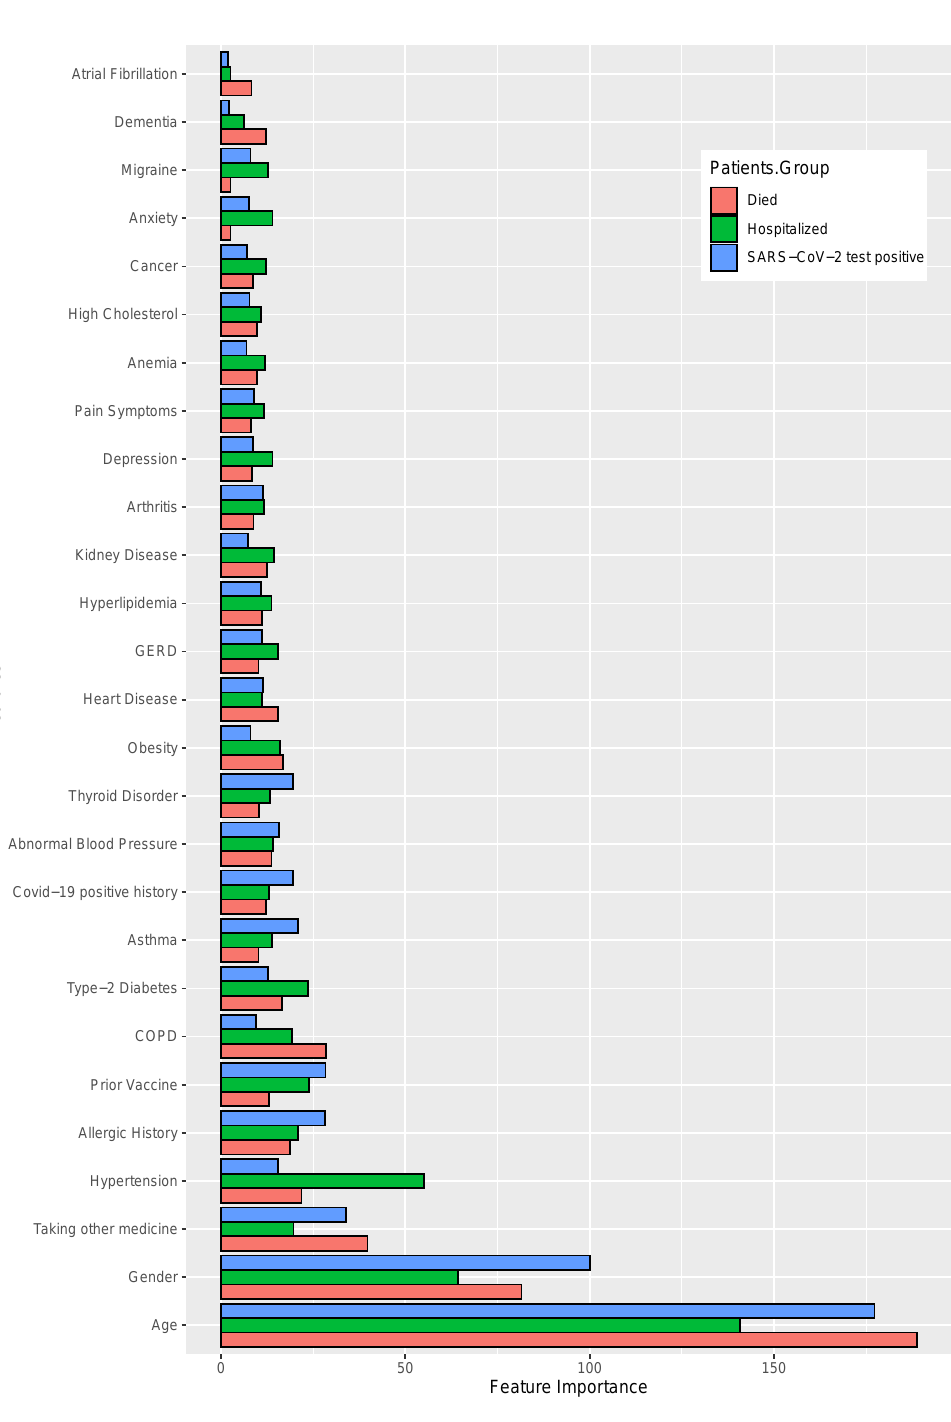
Figure 7. The features ranking according to the coefficient values of the patients’ medical history, calculated after machine learning model training. ML model outcomes indicate that higher coefficient values are mostly close to the significant association of